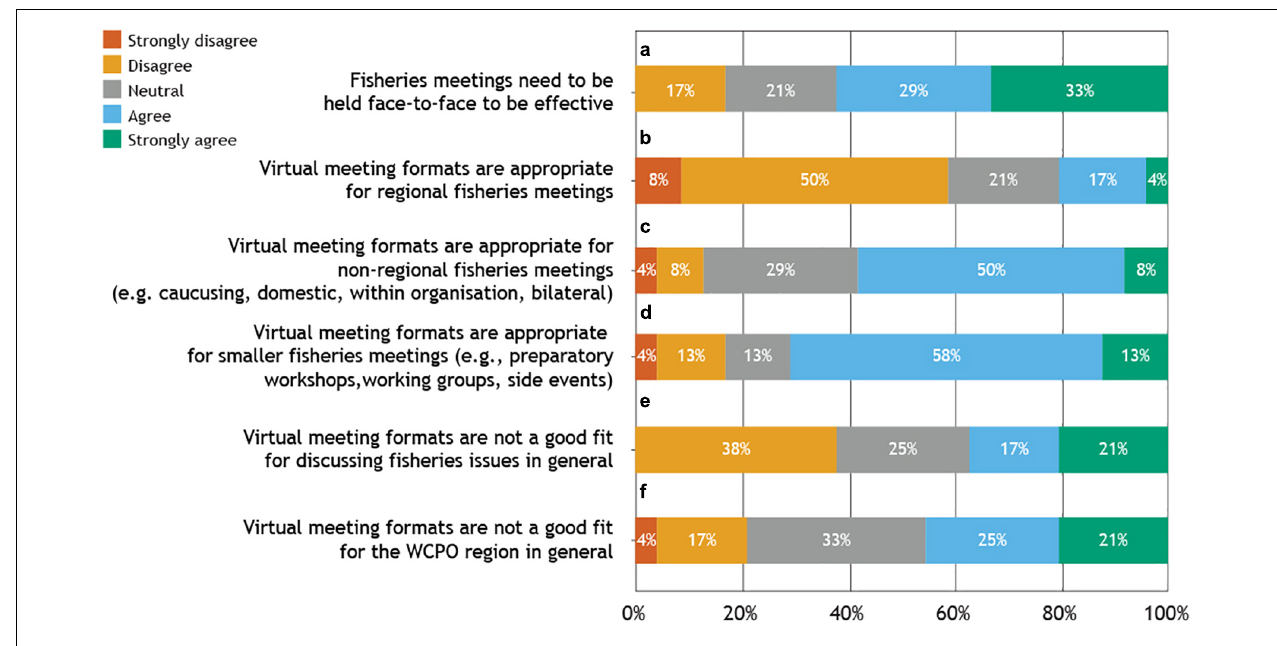
FIGURE 8 | Responses ( n = 24) to What is your level of agreement with the following general statements?